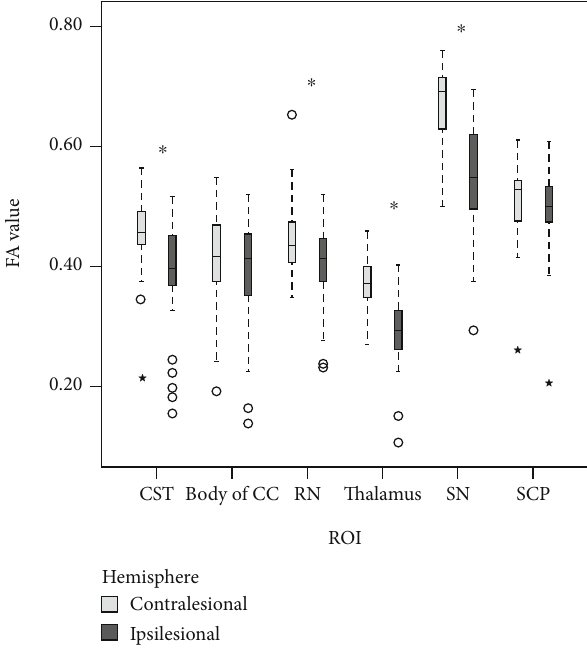
Figure 1: Di ff erences in contralesional and ipsilesional structural integrity in a priori regions of interest (ROIs). Reduced fractional anisotropy (FA) values were observed in the ipsilesional hemisphere. The median FA value is represented by the solid black line; circles and stars represent outliers. The range lines indicate the limits of the fi rst and third quartile of the interquartile range. CST: corticospinal tract; CC: corpus callosum; RN: red nucleus; SN: substantia nigra; SCP: superior cerebellar peduncle. ∗ p < 0 : 01 for di ff erences between